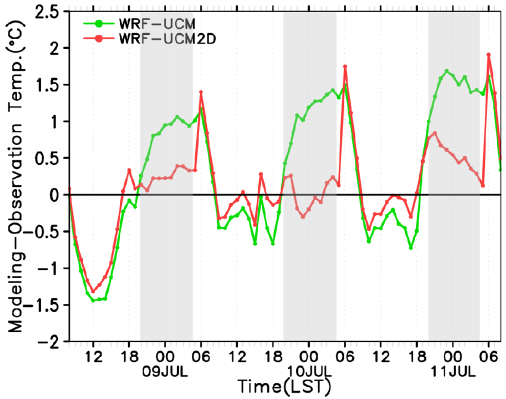
Figure 7. Difference between simulated and observed mean diurnal variation of temperature at 21 non-urban